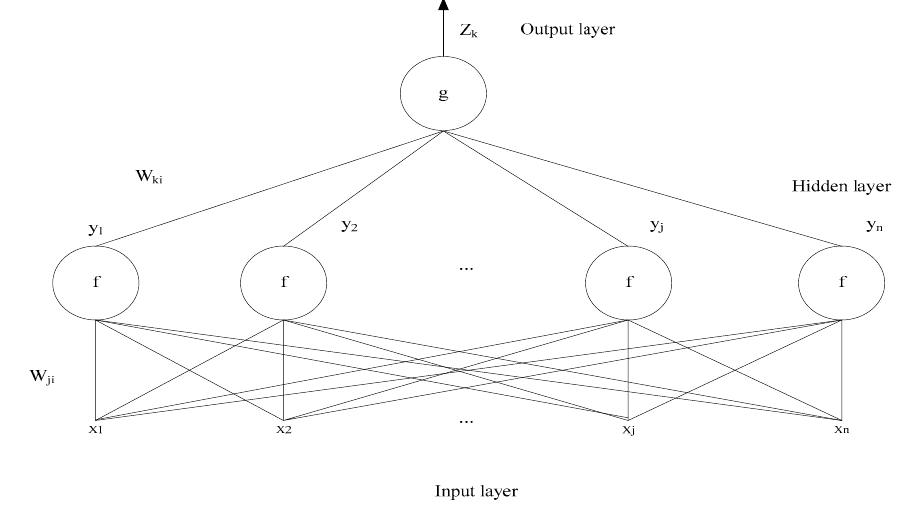
Figure 1. Schematic diagram of the BP neural network.